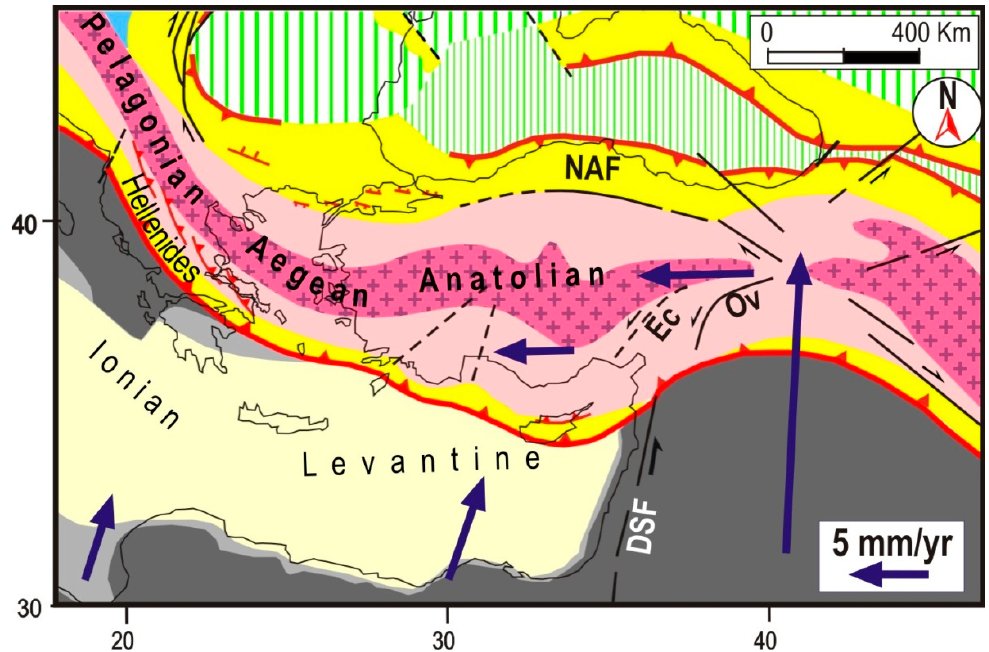
Figure 7. Late Miocene–early Pliocene paleogeographic setting, preceding the collision between the Aegean Tethyan belt and Adria. Ec—Ecemis fault; Ov—Ovacik fault. Symbols, colors and other abbreviations as in Figure 5.